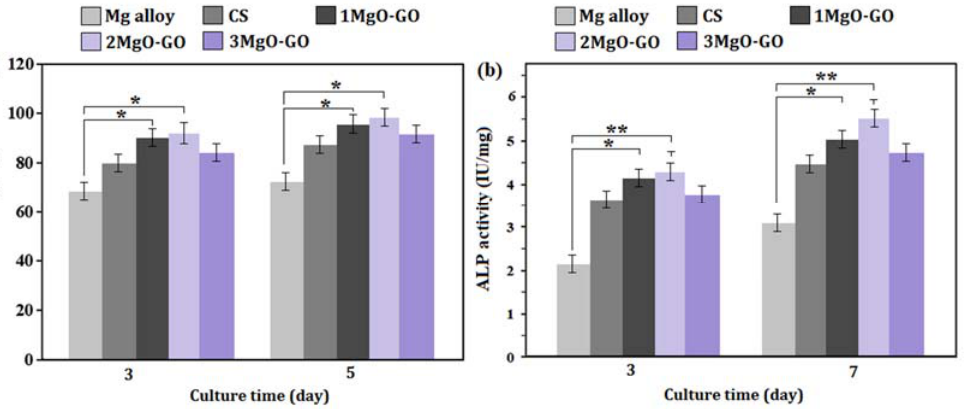
Figure 11. ( a ) Cell viability, and ( b ) ALP activity of MG63 cells cultured for various times on uncoated Mg, and Mg alloys coated with CS, CS/1MgO-GO, CS/2MgO-GO, and CS/3MgO-GO (* p < 0.05, and ** p < 0.01).